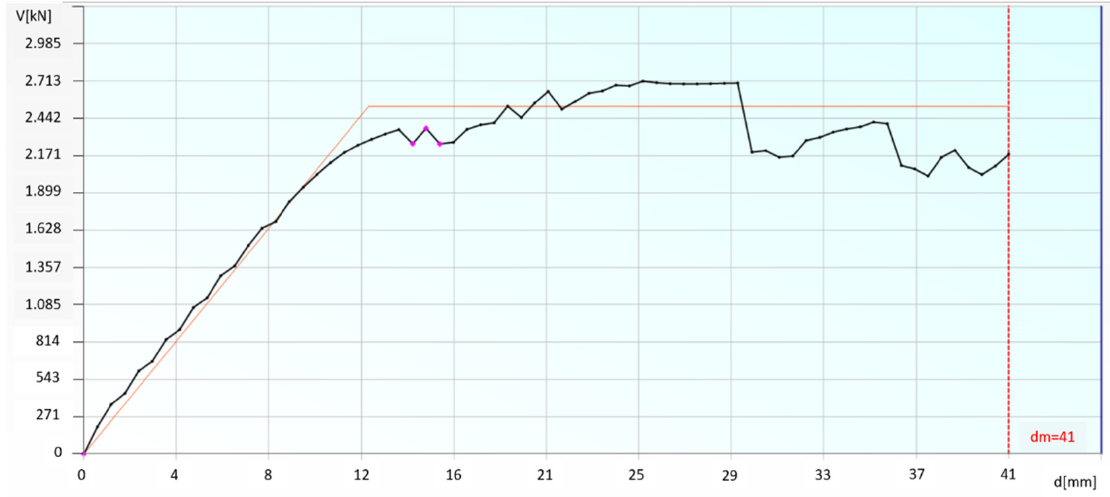
Figure 16. Capacity curve (black) and its bilinear idealization (orange) for x -direction. Buildings 2021 , 11 , x FOR PEER REVIEW 14 of 23